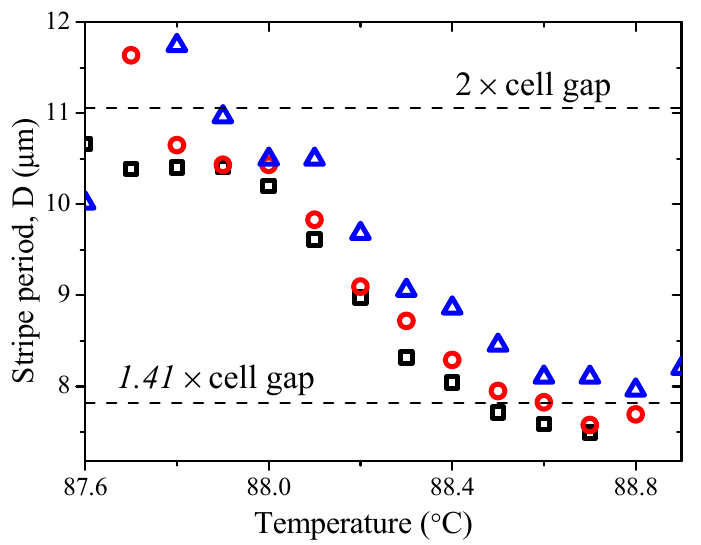
Figure 12. The observed stripe periodicity in a twisted cell as a function of temperature on cooling. Material used is MGTP7. The cell gap d = 5.53 µm, of a commercial EHC ® 90° twist-aligned cell. Different symbols indicate the data collected from three different locations in the sample.